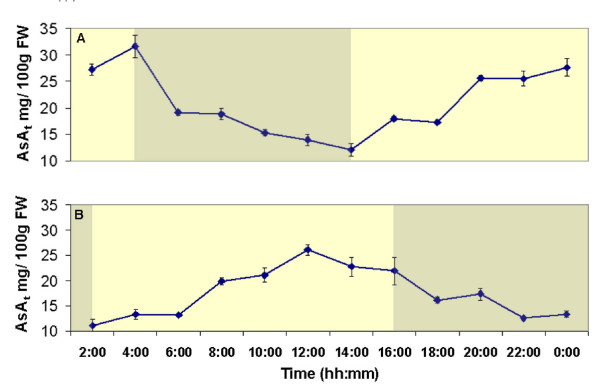
Changes in AsAt content of potato leaves as a function of light. Glasshouse grown plants were transferred to off-phased controlled environment chambers (panels A and B) 14 days prior to the start of the experiment. Environment chambers were on a 10 h dark – 14 h light cycle as indicated by the brown and yellow panels respectively. At the times shown, source leaves (leaves on the lower four nodes of each stem) were removed from each of three plants, ground in liquid nitrogen and extracted in 5% MPA, 5 mM TCEP (9:1 v/w) prior to quantification by HPLC. Values are represented as mean ± SE, n = 3.